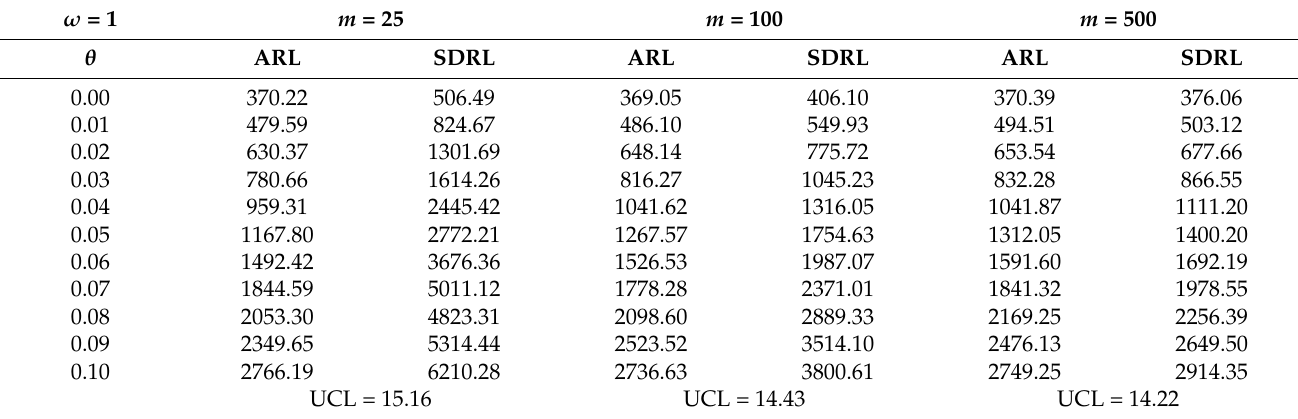
Table 3. ALR 0 and SDRL 0 values of the multivariate Shewhart control chart with outliers ( ω = 1).